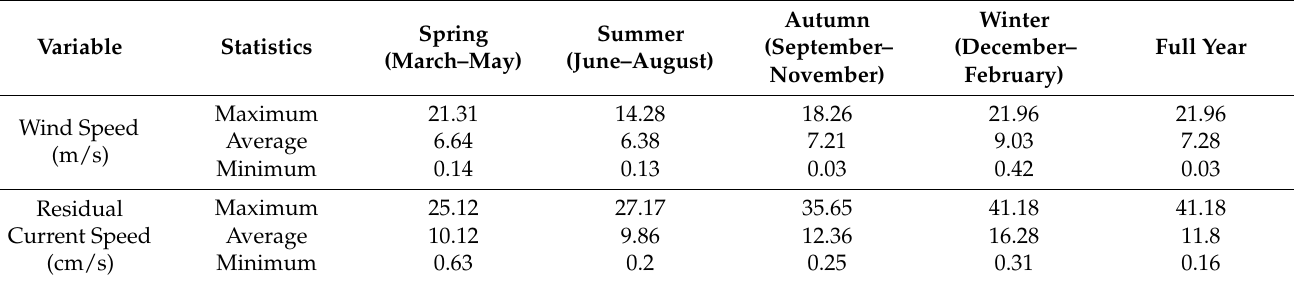
Figure 4. Vector time series of residual currents and winds during the analysis. Wind speed is between 0 and 22 m/s during the analysis period in the study area, and the residual current velocity magnitude is between 0 and 42 cm/s. The dominant wind direction is southwest, accounting for approximately 40% of the whole analysis year; while the northwest wind direction accounts for approximately one-third. This indicates that the wind is mainly westerly during the analysis period, this is consistent with the geographic location of the study area. From the statistical analysis, correlation coefficients of zonal and meridional components between wind vectors and residual currents vectors over the analysis year are 0.76 and 0.68, respectively. This further indicates that residual surface currents in the study area are significantly affected by wind. To further explore the influence of the wind on coastal surface residual currents in different seasons, detailed correlation analyses between wind and residual currents in four seasons were carried out as detailed below. Wind speed in spring is between 0 and 22 m/s, and the residual current velocity is between 0 and 26 cm/s. Figure 5 shows that the direction of residual currents is mainly west and northwest. While there is no obvious wind direction in the spring rose diagram in the wind directions, the directions of east and southwest take the larger proportions. Correlation coefficients of zonal and meridional components between wind speeds and residual currents speeds are 0.74 and 0.70, respectively. This indicates that wind is the